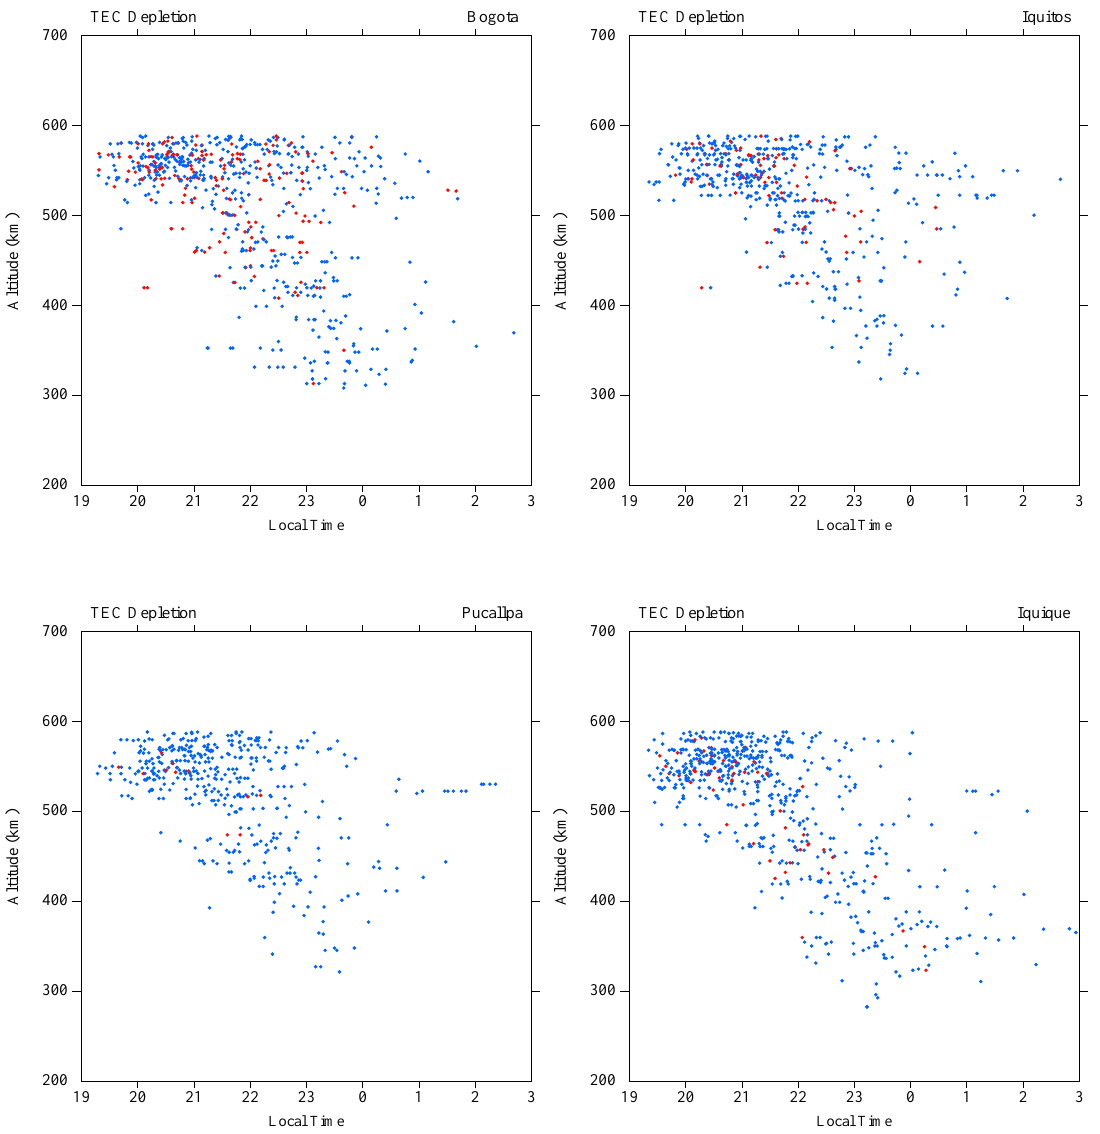
Fig. 11. hm F2 values measured during the occurrence of TEC depletions measured with the network of GPS receivers. TEC depletions larger than 30 TEC units are depicted as red dots; values smaller than 30 units are indicated by blue dots. Mass plots for only 4 stations are presented